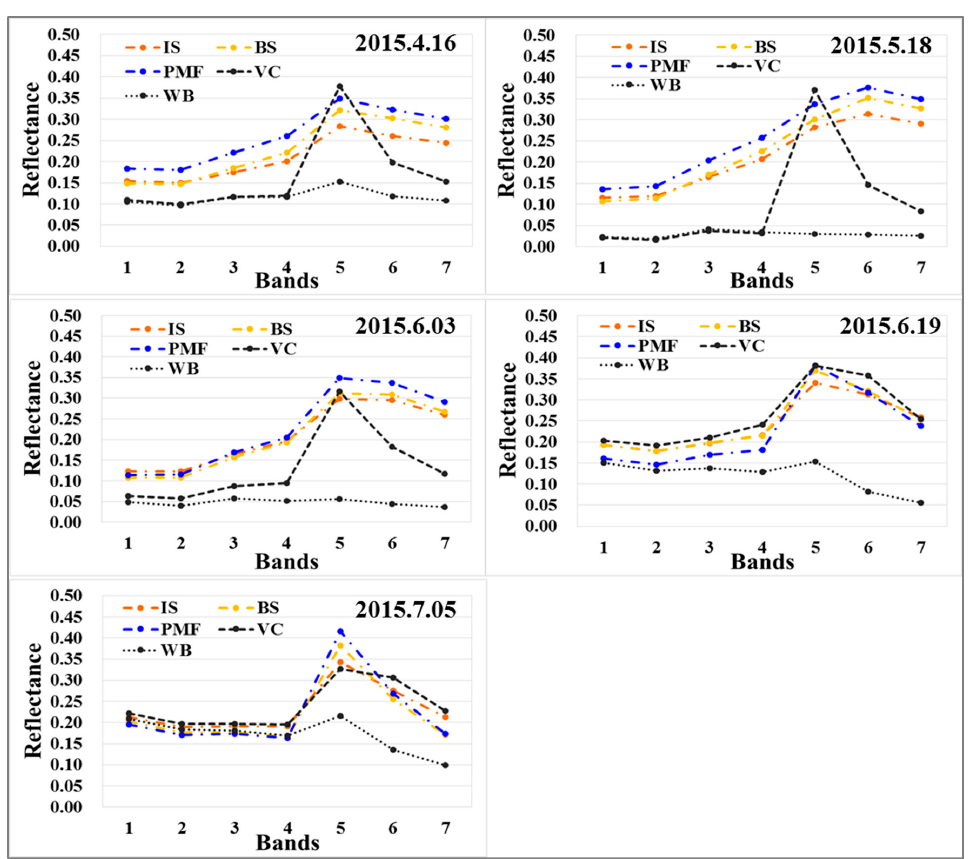
Figure 4. Spectral response of typical land cover types. 1: Coastal Aerosol, 2: Blue, 3: Green, 4: Red, 5: NIR (near-infrared), 6: SWIR1 (short-wave infrared), 7: SWIR2.